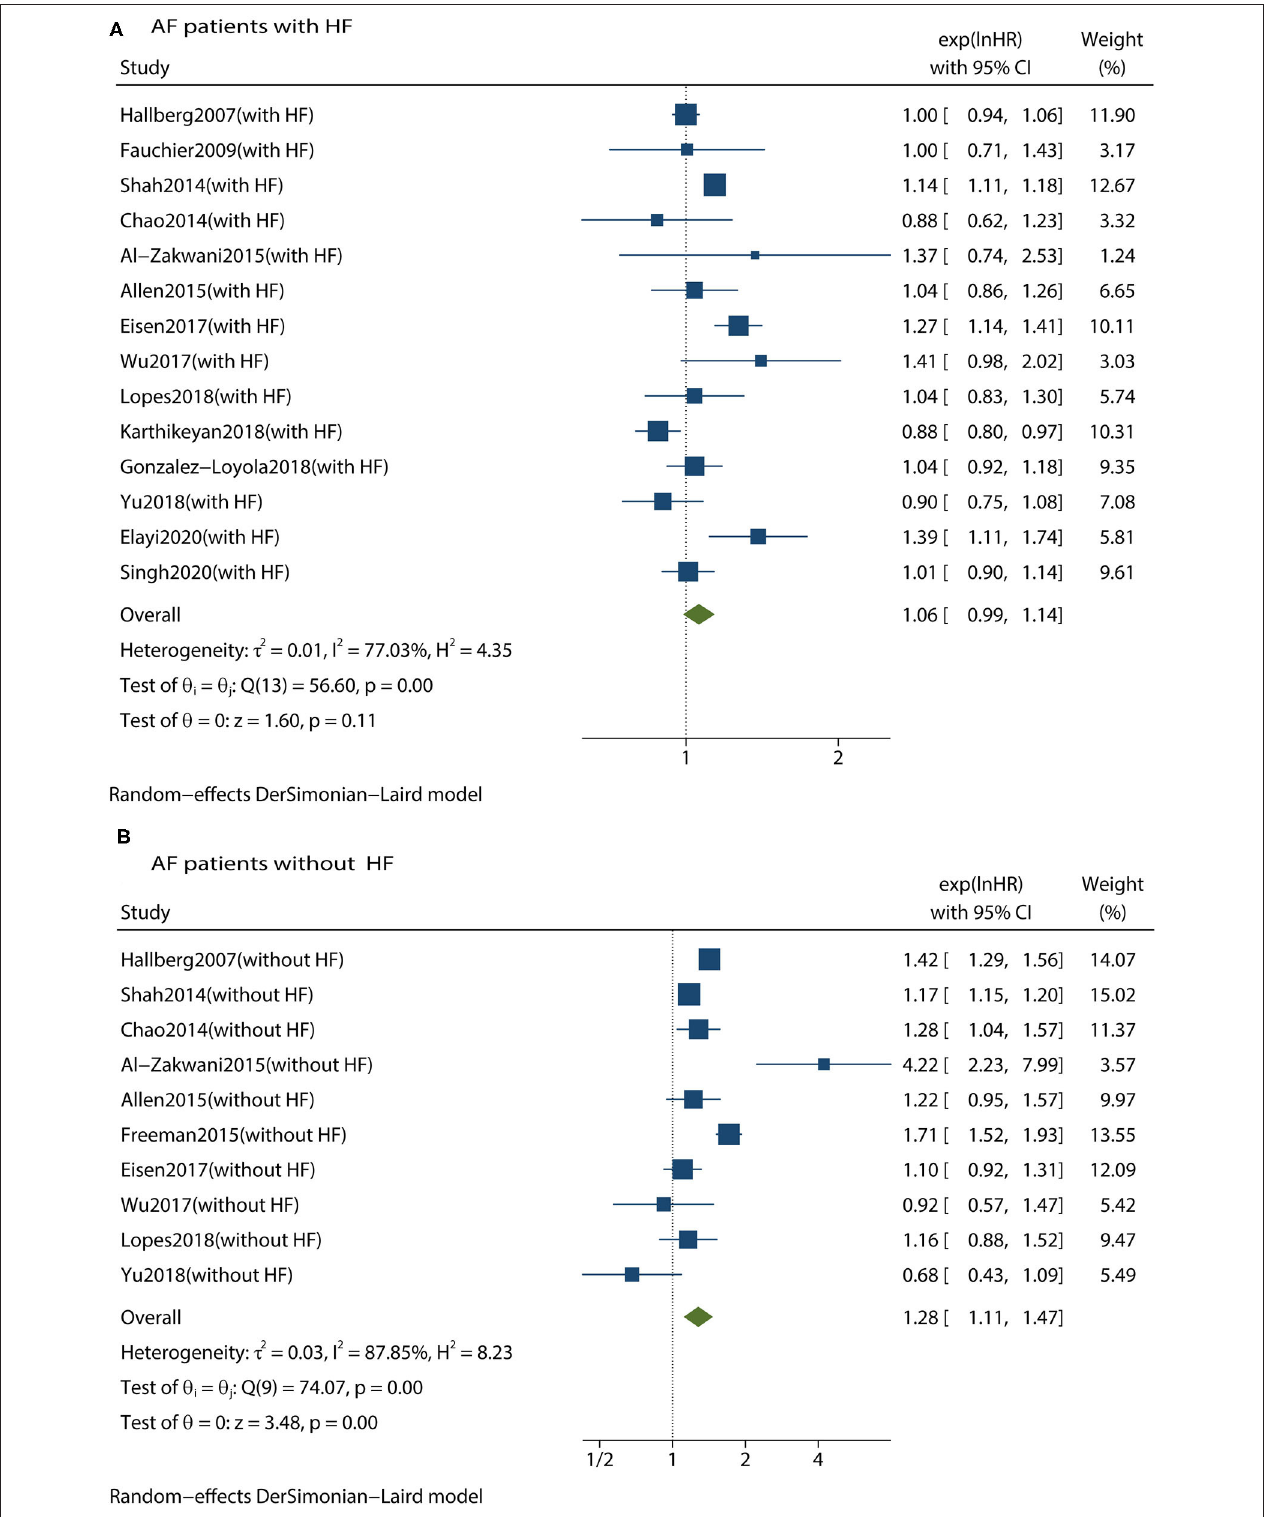
FIGURE 4 | Forest plot showing the effects of digoxin therapy compared with no digoxin therapy on all-cause mortality in AF patients with HF (A) or in AF patients without HF (B) . AF, atrial fibrillation; HF, heart failure; HRs, hazard ratios; CIs, confidence intervals.